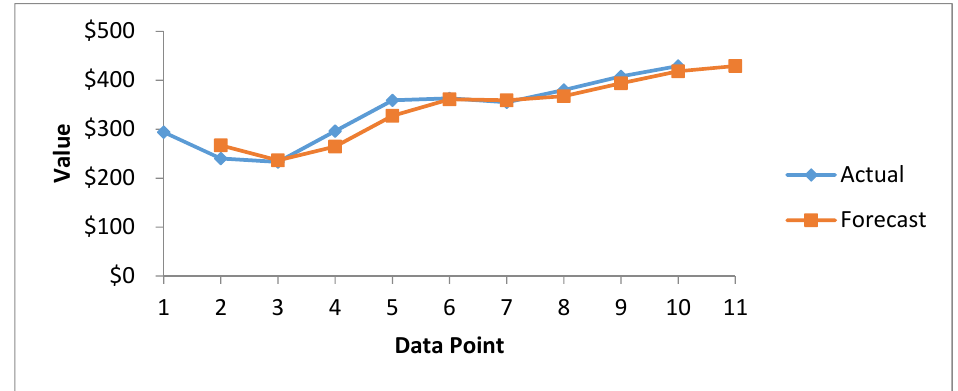
Figure 8. Forecasting graph of Healthcare Record Cost since 2010–2020 through SMA method.